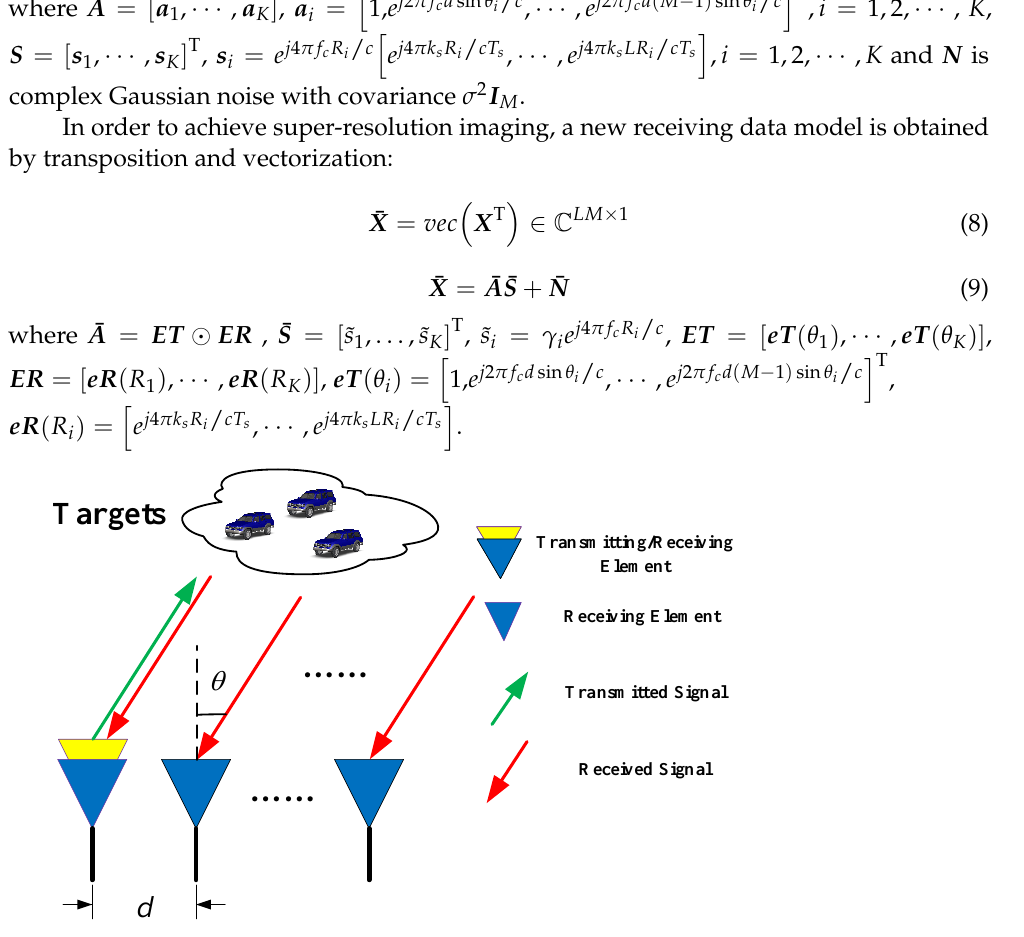
Figure 3. A schematic diagram of the target localization